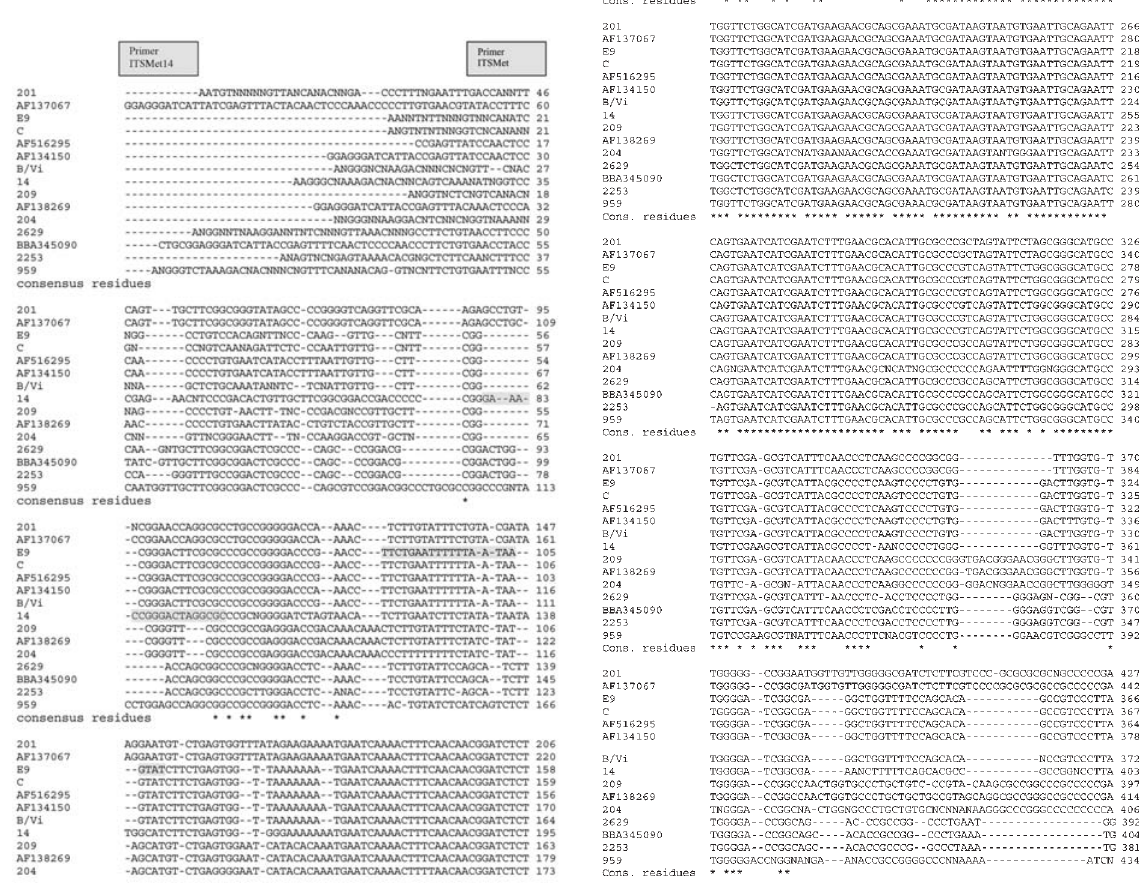
Figure 2 - Alignment of the nucleotide sequences of the ITS1 – 5.8S – ITS2 region of the strains investigated by us ( Metarhizium anisopliae var. anisopliae strains E 9 , B/Vi, C and 14; Metarhizium album strain 201; Metarhizium flavoviride strains 204 and 209; Beauveria bassiana strains 959, 2253 and 2629) with GenBank ITS sequences for M. a. anisopliae (AF516295 and AF134150), M. album (AF137067), M. flavoviride (AF138269) and B. bassiana (BBA345090). The specific primers ITSMet and ITSMet14 developed by us are indicated by gray boxes. *consensus